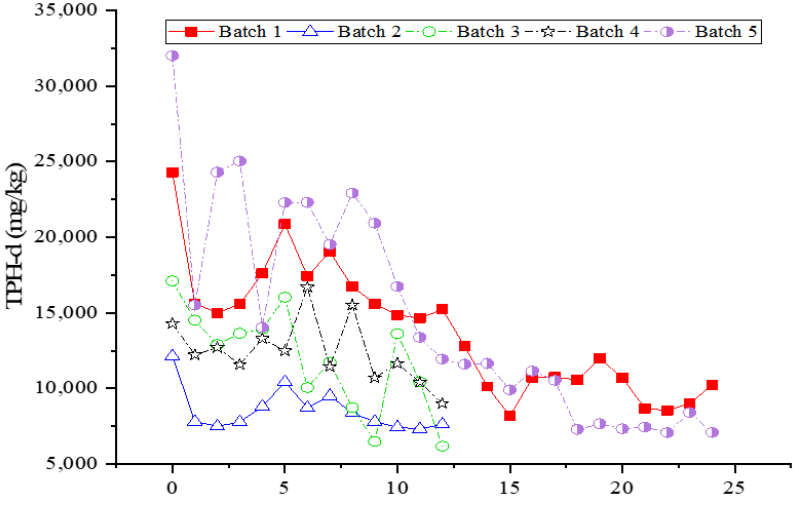
Figure 5. Degradation of diesel (TPH-d concentration) in soil by ozone and perozone treatment.